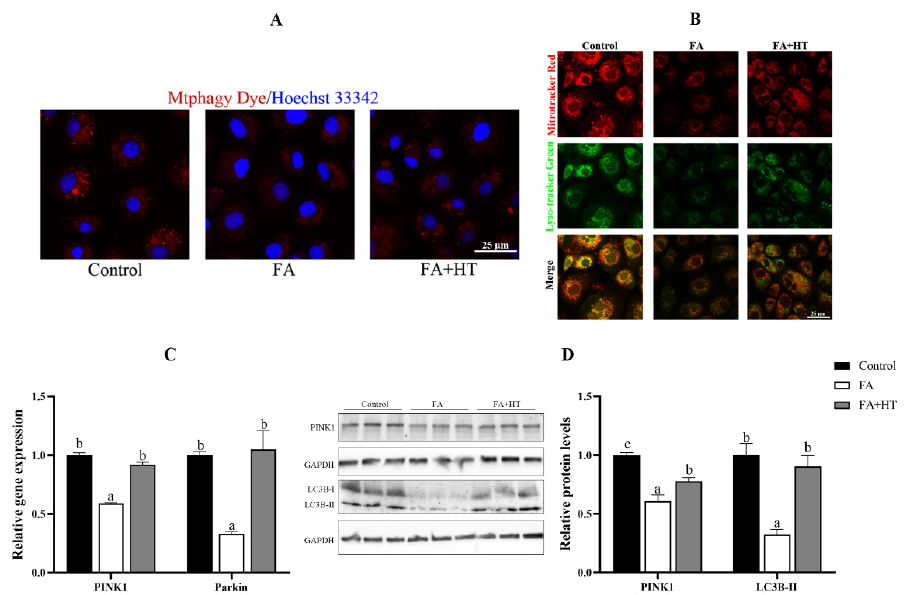
Figure 7. Staining of mitochondrial autophagosomes by Mtphagy Dye (red) in ZFL cell ( A ). Nuclei are highlighted with Hoechst 33342 (blue). The co-localization of Mitochondrion (Red) and Lysosome (Green) in ZFL cell (yellow dots), ( B ). Scale bar = 25 µ m. The relative gene expression level of PINK1 and Parkin ( C ). The relative level of PINK1 and LC3B-II proteins in ZFL cells ( D ). All values are exhibited as mean ± SE. The values with different superscripts (a, b, c) are significantly different at p < 0.05 (Tukey’s test).